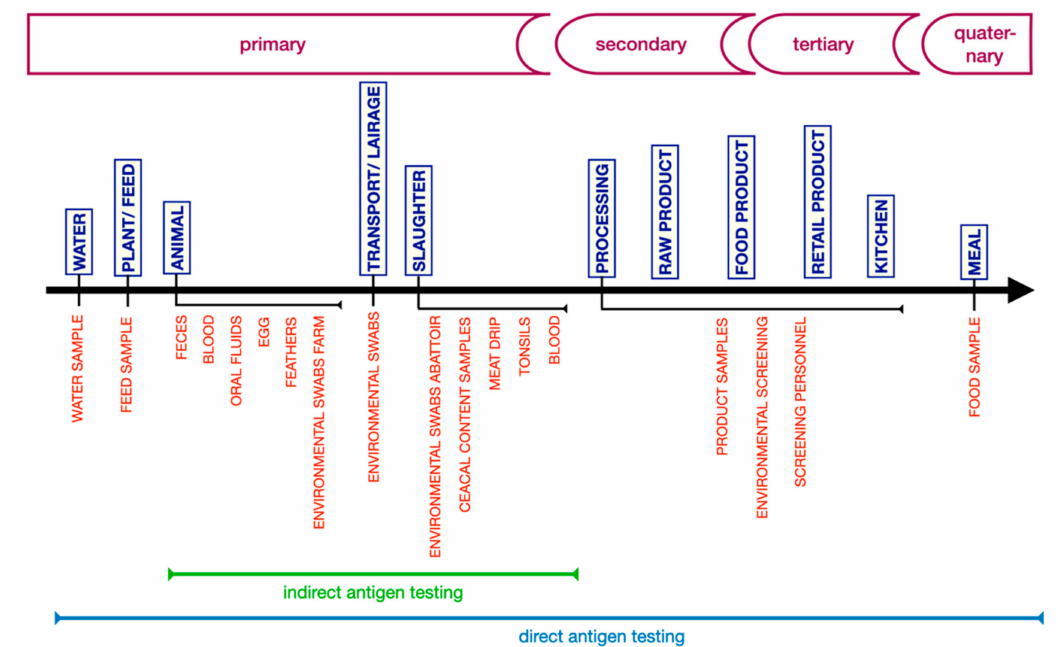
Figure 2. When, what, and how to screen in the animal food production chain (dark blue color) to secure food safety with respect to microbial hazards. Hazard critical point analysis will reveal optimal sampling moments. The sectors (purple color) which determine the type of sampling (red color) and testing (green and light blue colors) possible are indicated. The primary sector includes the pre-harvest stage until slaughter and comprises reproduction, egg and milk, fattening, transport, and slaughter phases. The secondary sector includes all food-processing steps converting milk, eggs, and meat into complex products. The tertiary and quaternary sectors include wholesale, street vendors, catering, institutional kitchens, and finally private kitchens and (domestic)